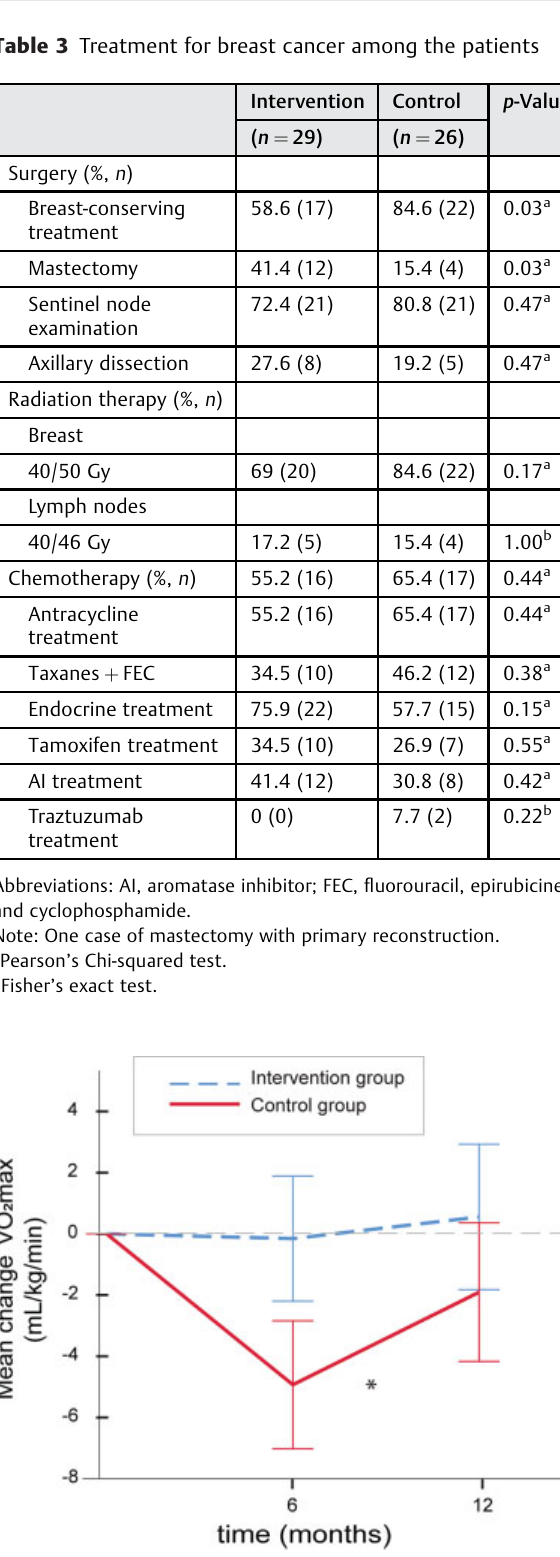
Fig. 2 Maximal oxygen uptake in the two study groups during the study period. The lines show mean (95% con fi dence intervals) differ- ences from baseline in VO 2max levels in the intervention group (blue stippled line, n ¼ 29/22/21 at 6 and 12 months, respectively) and the control group (red line, n ¼ 25/24/23 at 6 and 12 months, respec- tively). The asterisk denotes a signi fi cant difference (mixed model adjusting for baseline values, (cid:6) p ¼ 0.005) between the two study groups with regard to the main group